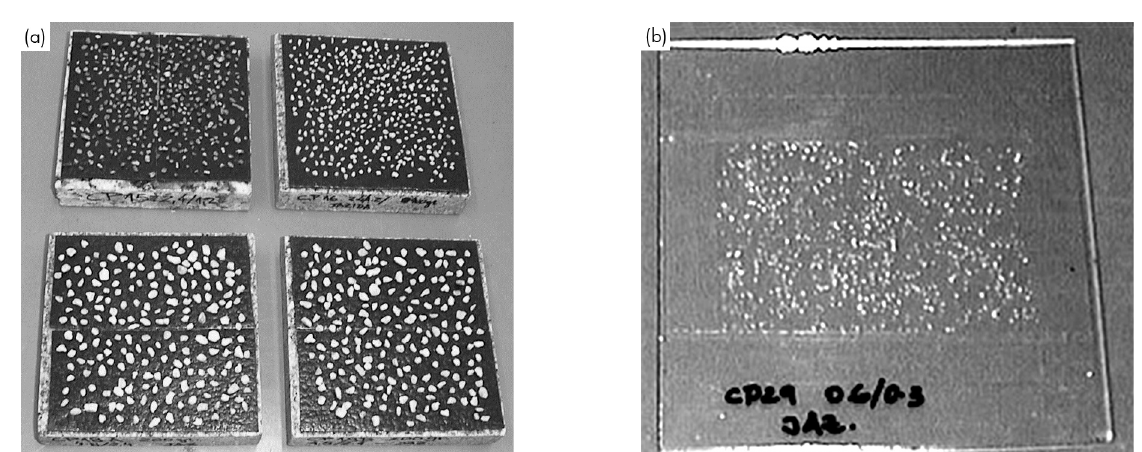
Figura 1. Amostras das frações de areia mais grossas (a) e mais finas (b) preparadas para aquisição das